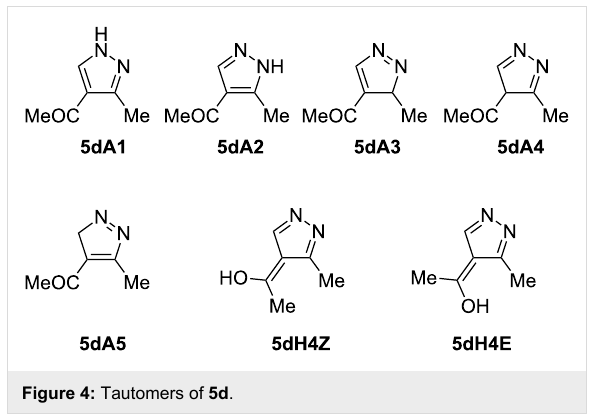
Figure 4: Tautomers of 5d